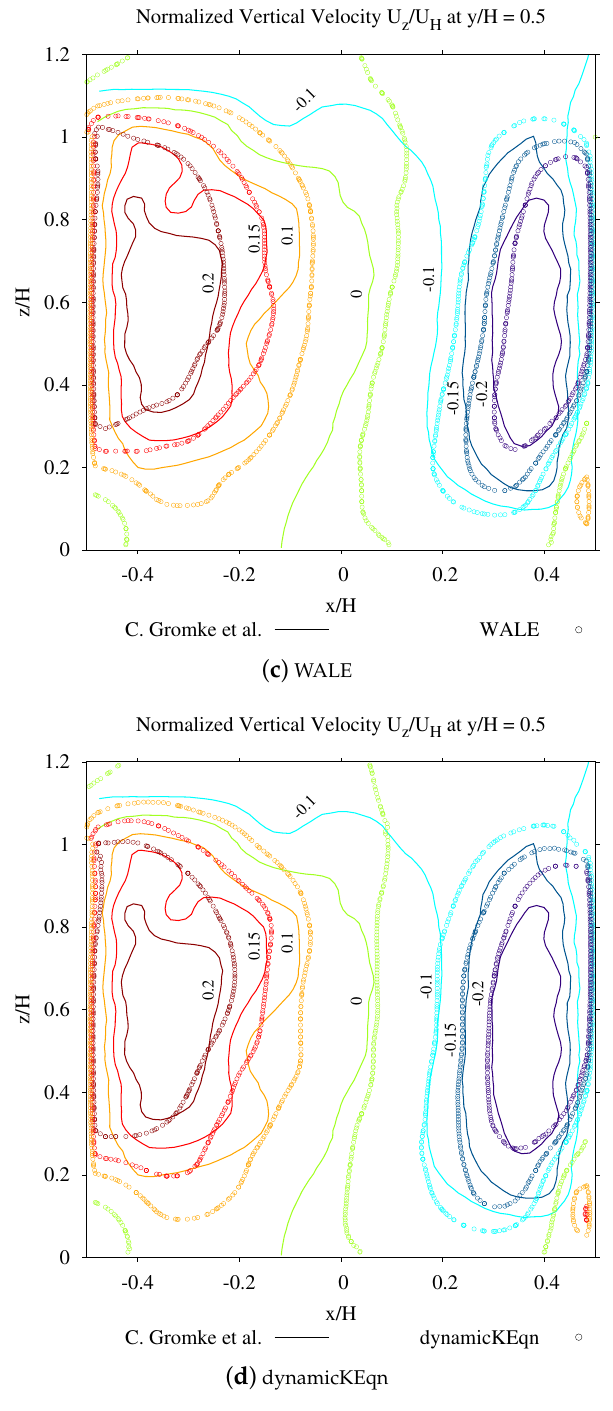
Figure 4. Comparison of simulation and experimental results for four different subgrid scale tur- bulence models. ( a , b ) show the static models, ( c , d ) the dynamic models. The normalized vertical velocity, with U H as a reference, is shown, which is the inlet velocity at height H. The contours from the experiment are plotted as solid lines and those from simulations as dotted lines, where colors indicate the velocity